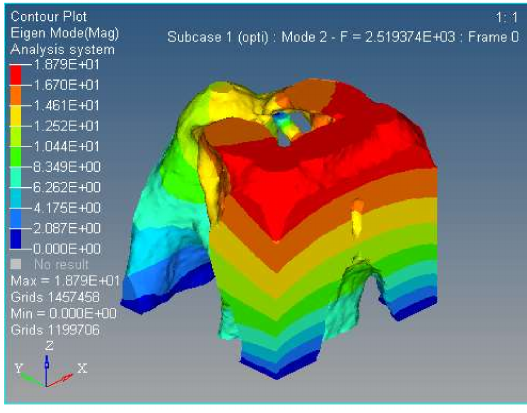
Figure 13. Second order modal of the proposed spatially compliant mechanism with three rotational